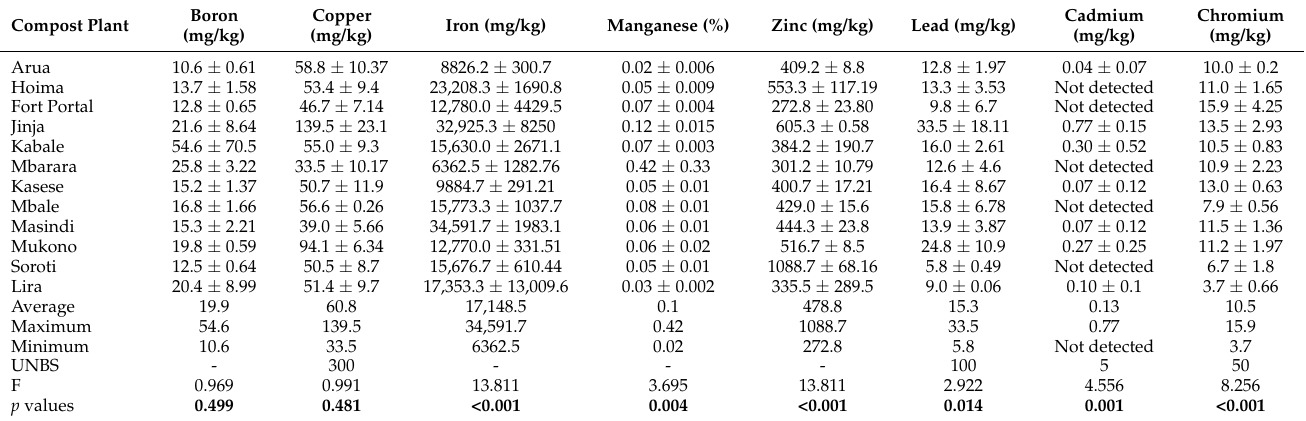
Values represent the mean of three replicates ± SE (standard errors). Values of the probability of PERMANOVA analysis are indicated. Significant p -values are indicated in bold. Table 2. Heavy metal parameters of MSWC from 12 CDM plants in